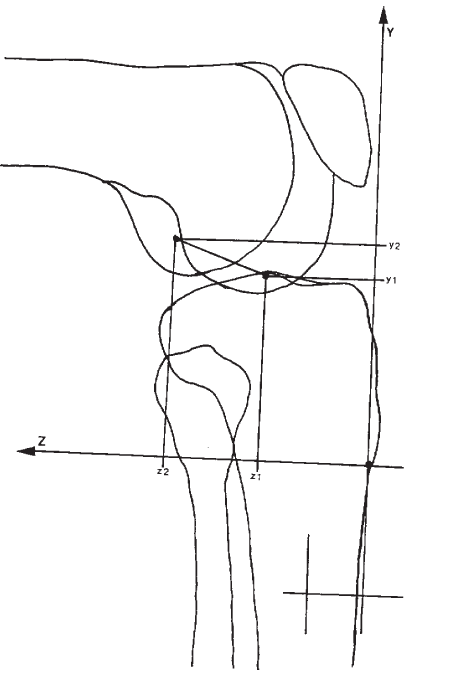
Figure 4 - Schematic drawing of Figure 3, showing the segment described as the posterior bundle of the anterior cruciate ligament and its projection on the x and y coordinates drawn in relation to the tibial anatomic axis. The value of the segment of each bundle was found by subtracting the coordinate values referring to femoral and tibial attachment, as follows: for the length -z . in the x-axis, X = x -x , and for length in the y-axis, Y = y 2 1 2 1